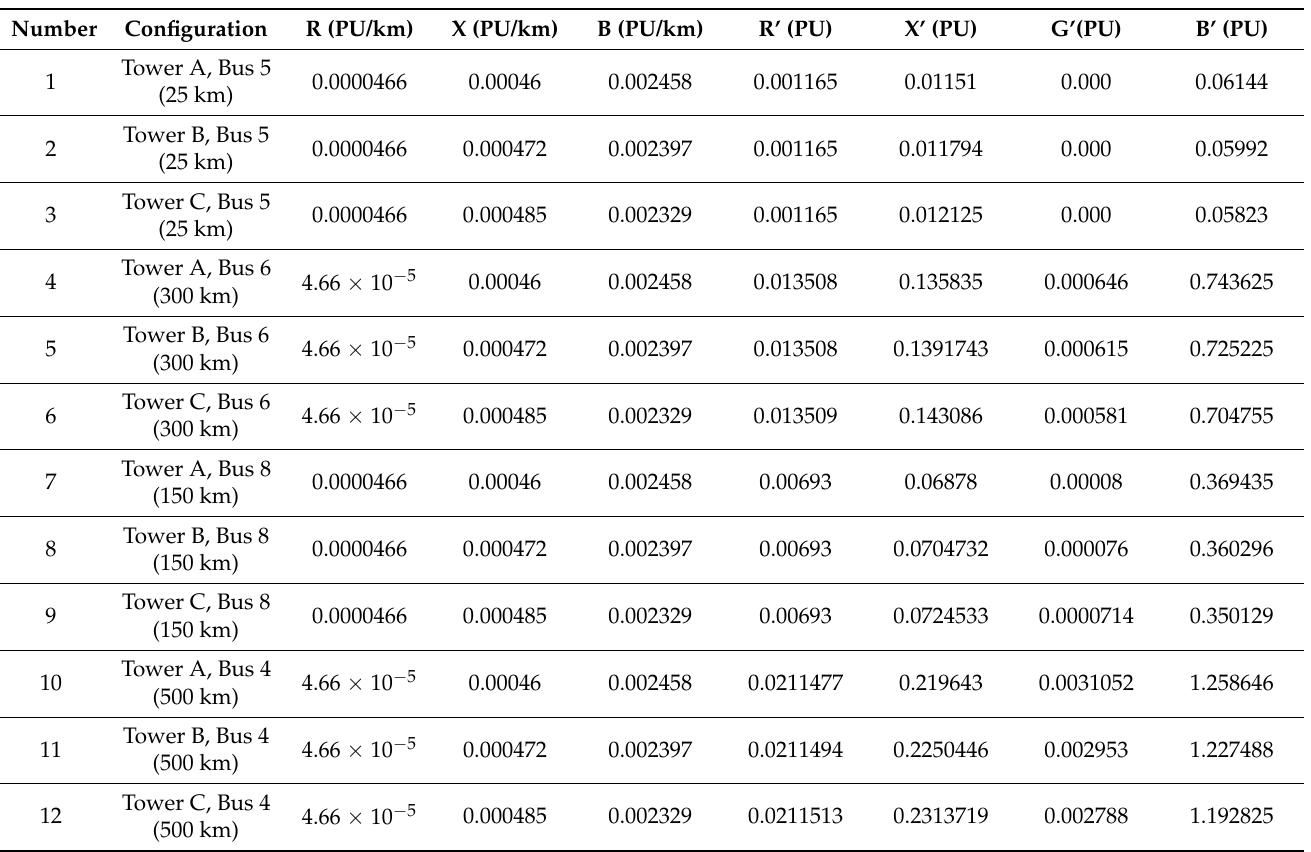
Table 7. Parameters of the